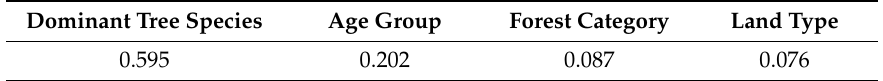
Table 3. The independent q values of the four GFs.